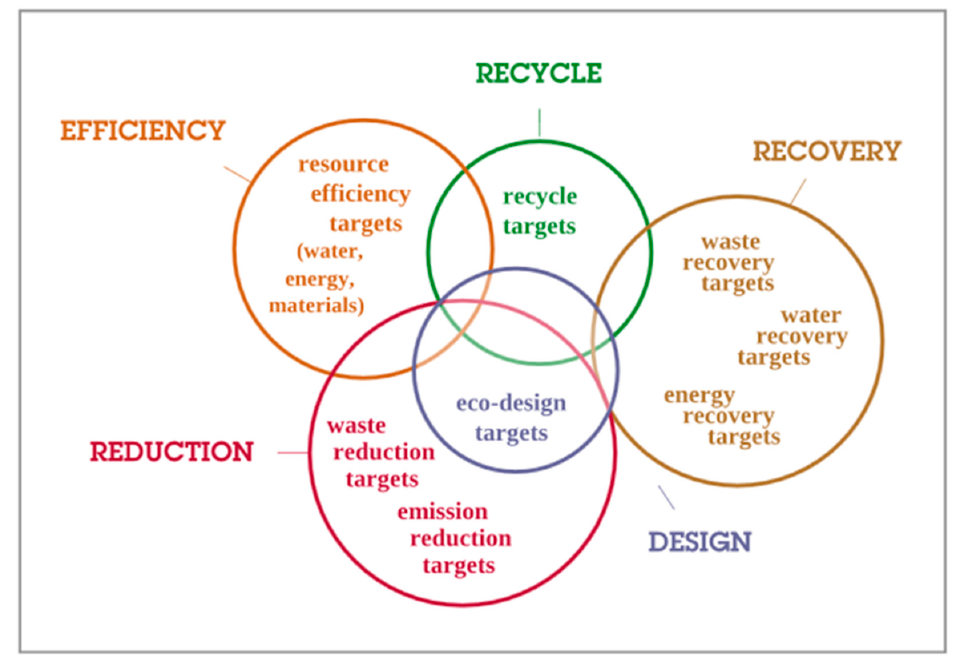
Figure 2. Main existing CE targets [21].